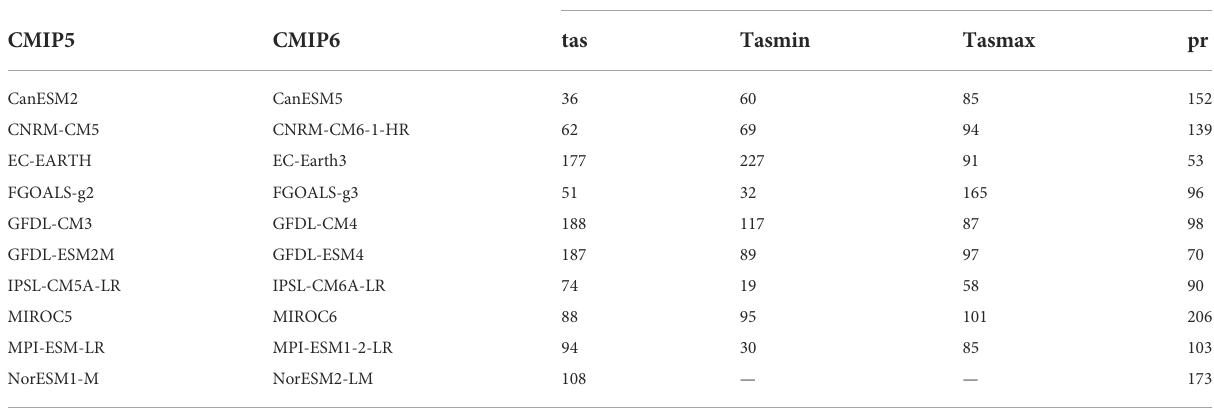
TABLE 1Comprasionofroot meansquare error(RMSE)ofthemeanannualcycleofstudiedvariables between selected CMIP6andCMIP5 GCMpairs. The differences are shown relatively, values lower than 100 implying better performance of CMIP6 GCM than its CMIP5 counterpart.